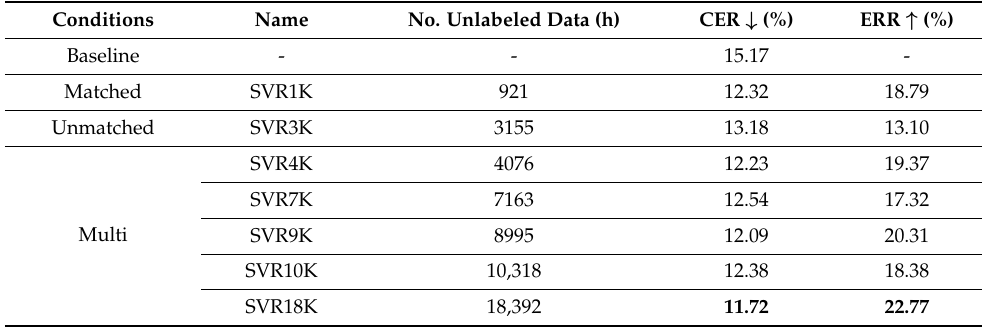
Table 6. The ASR results of KsponSpeech (965 h) for the four conditions were trained with the whole dataset as the supervised data. The relative error with respect to the Baseline condition is also indicated. Bold denotes the best